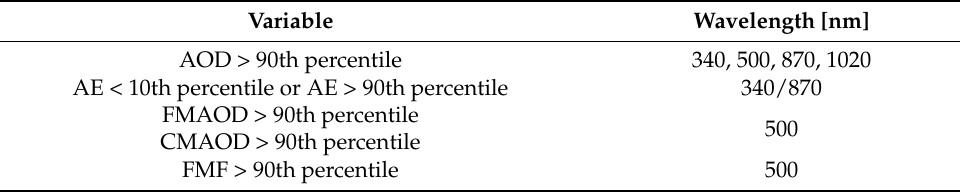
Table 1. Criteria to define the values outside the climatological limits.